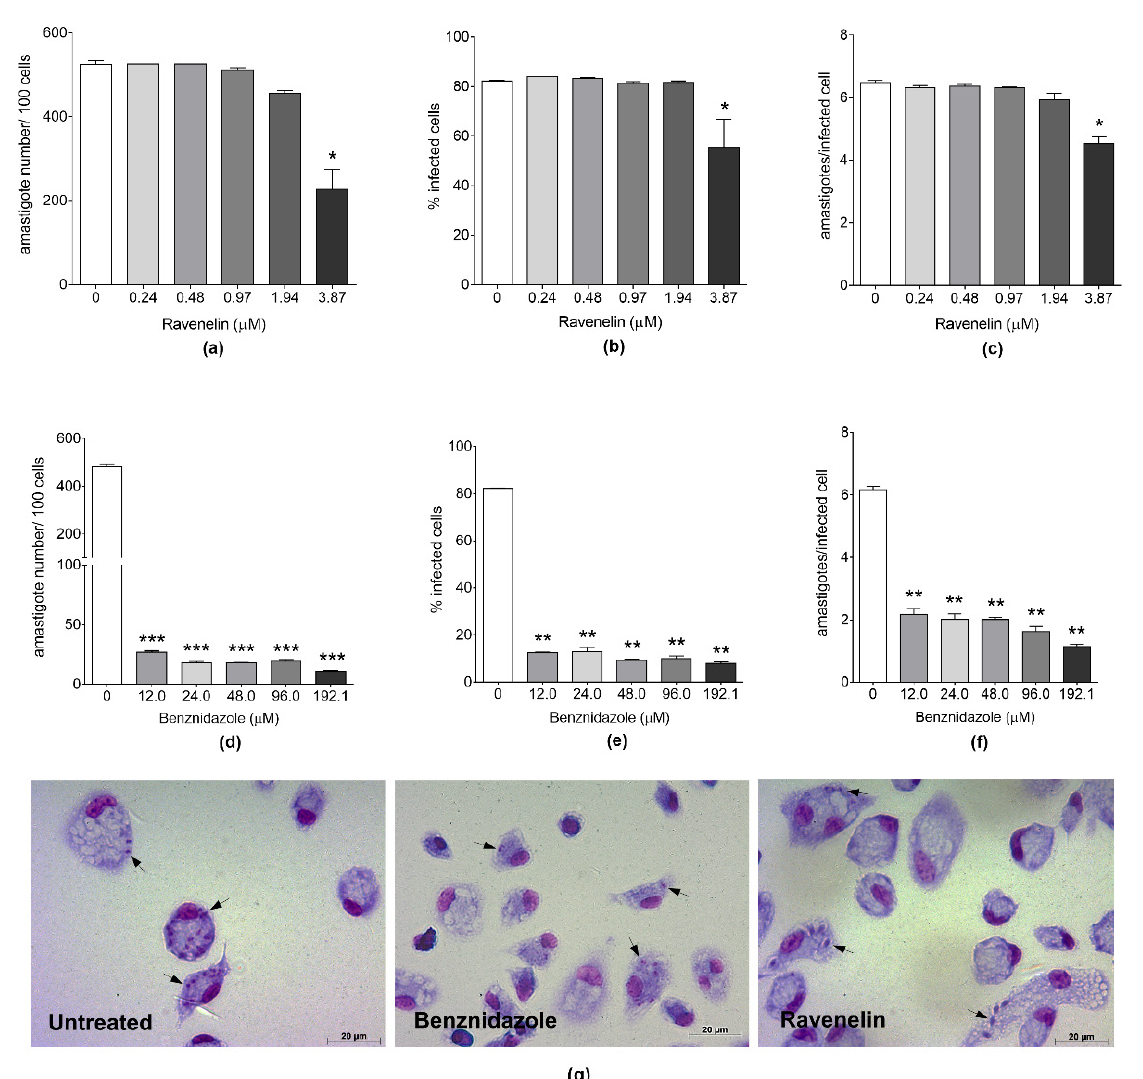
Figure 2. Infection parameters of BALB/c peritoneal macrophages infected with T. cruzi and treated for 24 h with ravenelin or benznidazole. ( a – f ) Parameters of infection and ( g ) light microscopy after ravenelin or benznidazole treatment at 3.87 µ M or 192.1 µ M, respectively. Intracellular amastigotes inside macrophages (black arrows). Data represent mean ± standard deviation of two independent experiments conducted in triplicate. * p < 0.05, ** p < 0.01 and *** p < 0.001, when compared to the untreated group by the Mann–Whitney test.